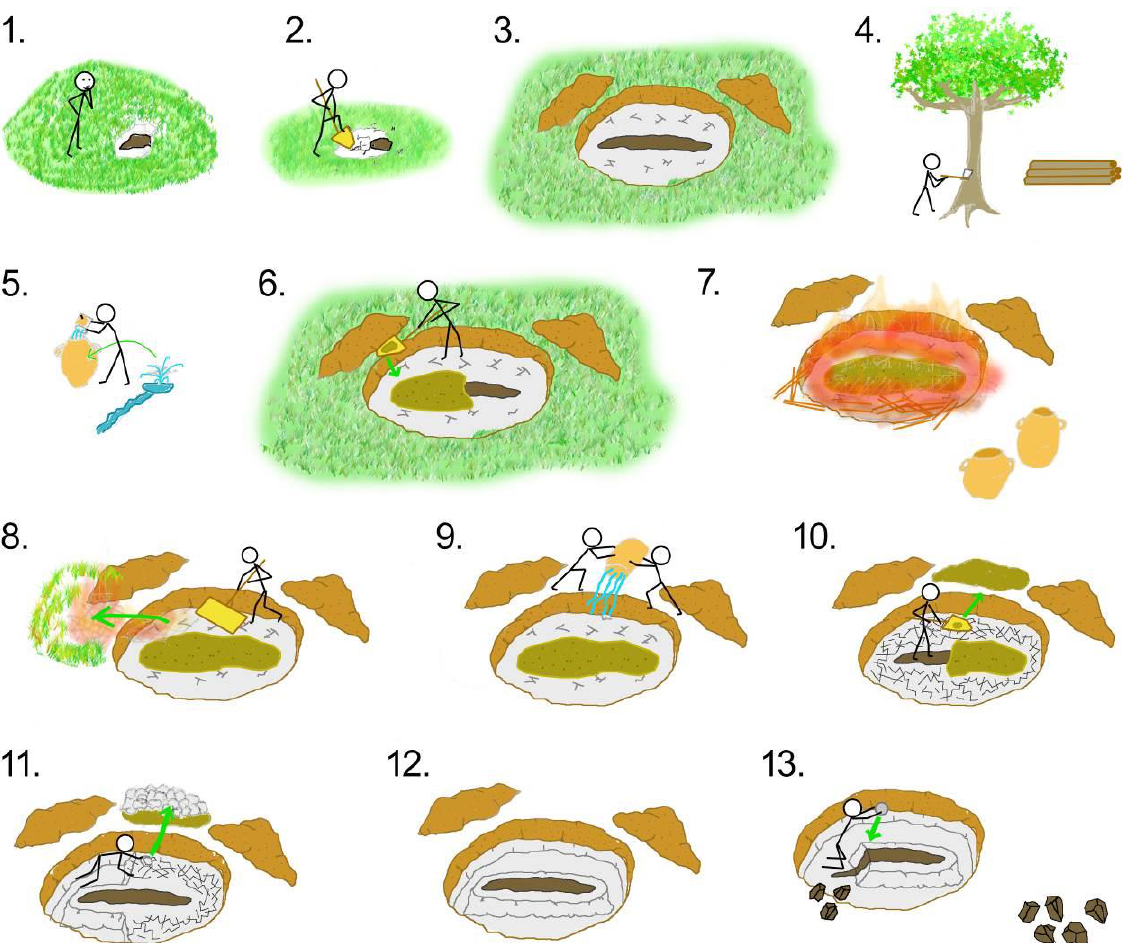
Figure 15. Diagram illustrating how chert can be mined by the fire-setting method. Stages: 1. to 3. finding and uncovering an outcrop of chert; 4. collecting wood; 5. collecting water; 6. covering the outcrop with soil; 7. making a fire over the limestone bedrock; 8. removing the embers; 9. pouring water on the hot limestone; 10. uncovering the chert; 11. & 12. removing the cracked limestone until only the chert band remains; 13. removing the exposed